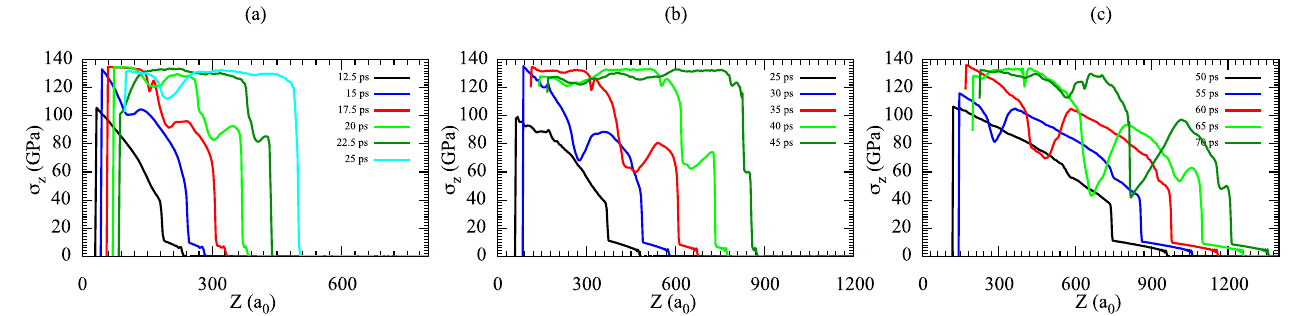
Figure 5. Stress profiles along the loading direction, Z, for the ramp rise time of 15 ps ( a ), 30 ps ( b ), and 60 ps ( c ), corresponding to Figure 3.